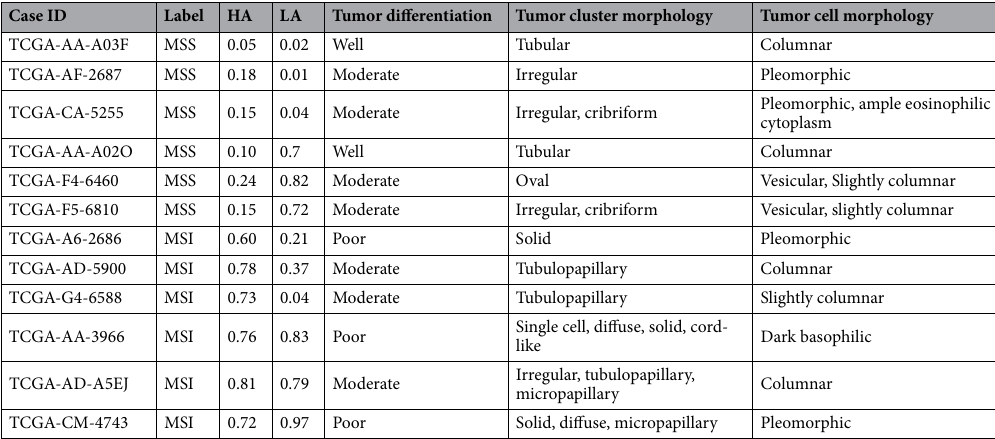
Table 2. Qualitative review of select cases. HA and LA indicate the scores of high and low-level approaches, respectively. A high score corresponds to MSI (= 1). See Supplementary Fig. 2 for additional details for select cases. MSS microsatellite stable, MSI microsatellite